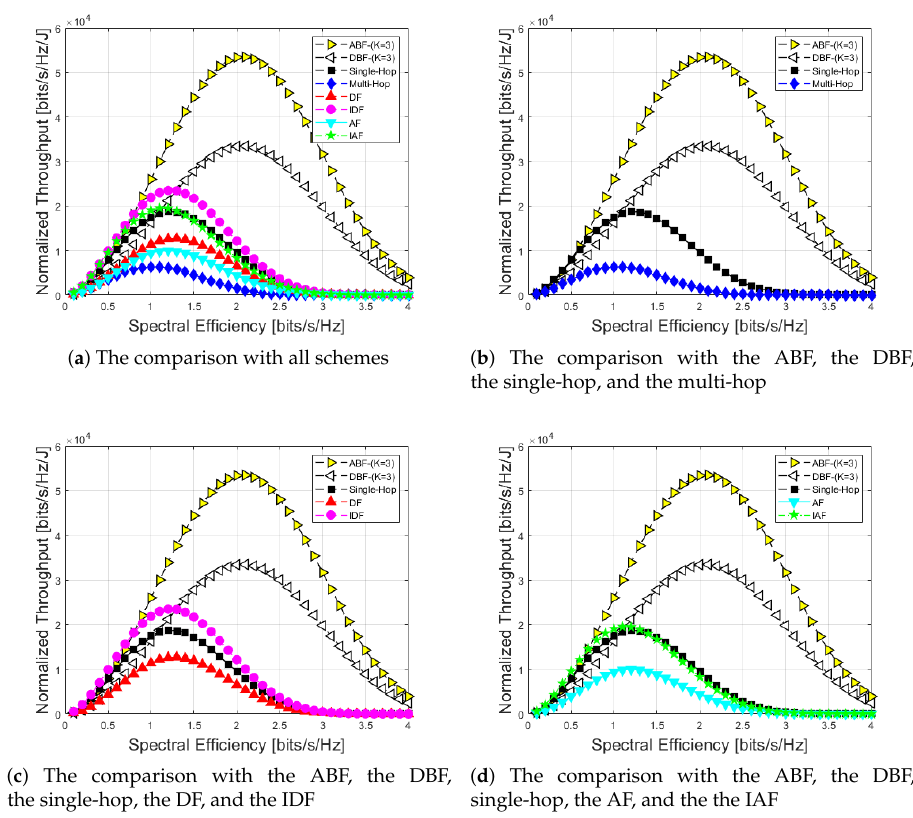
Figure 10. Normalized throughput vs. spectral